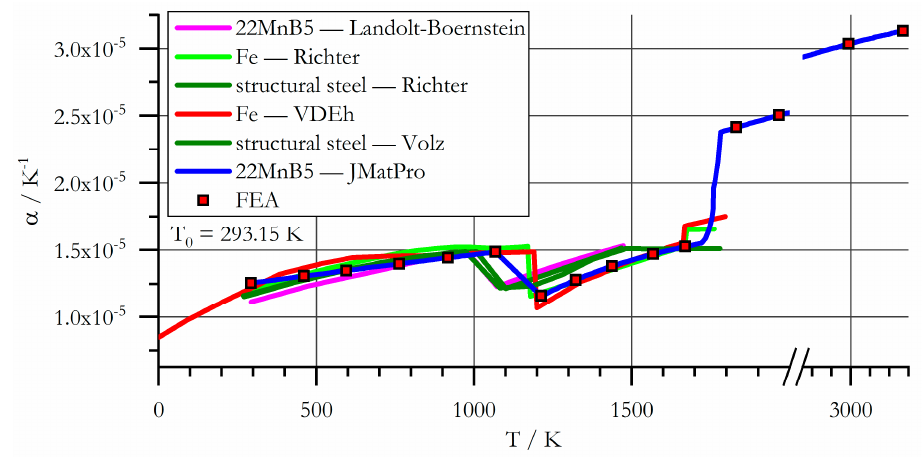
Figure 7. Coefficient of thermal expansion of 22MnB5.